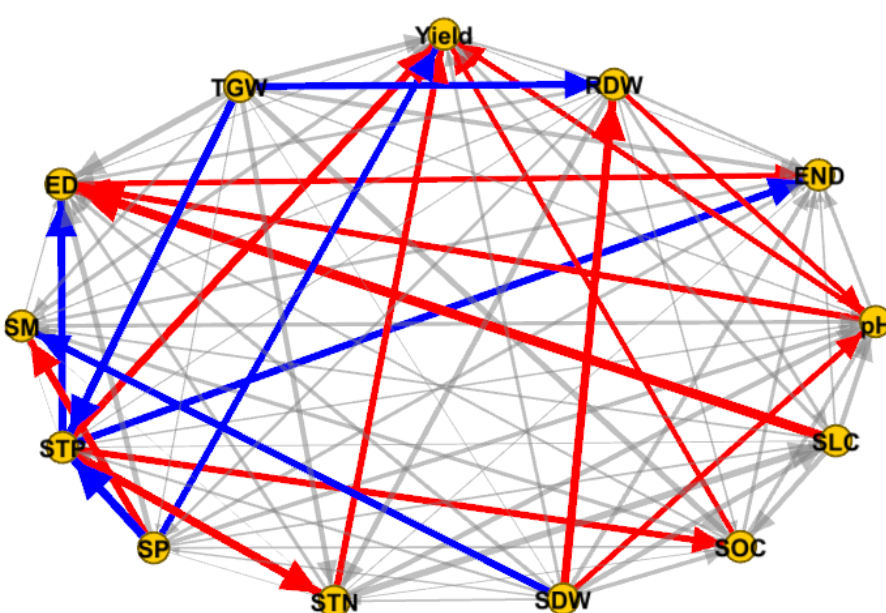
Figure 2: Network of the BFBF practice. Positive and negative correlations are shown in red and blue colors, respectively. The width of the arrows represents the strength of the relationships.